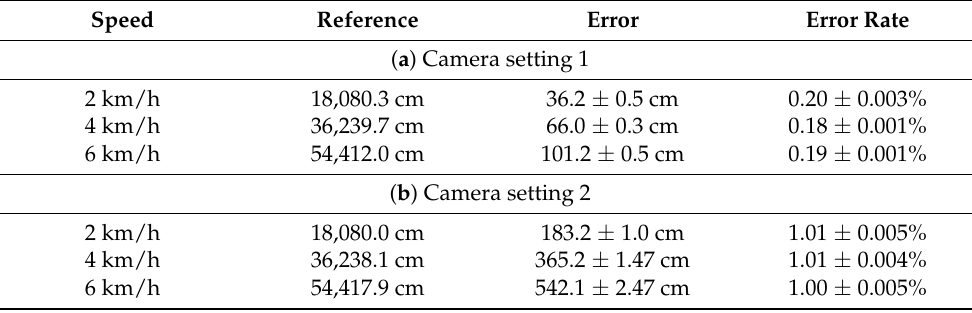
Total travel displacement (TTD) errors of the tests without pedestrian walking (mean ± standard